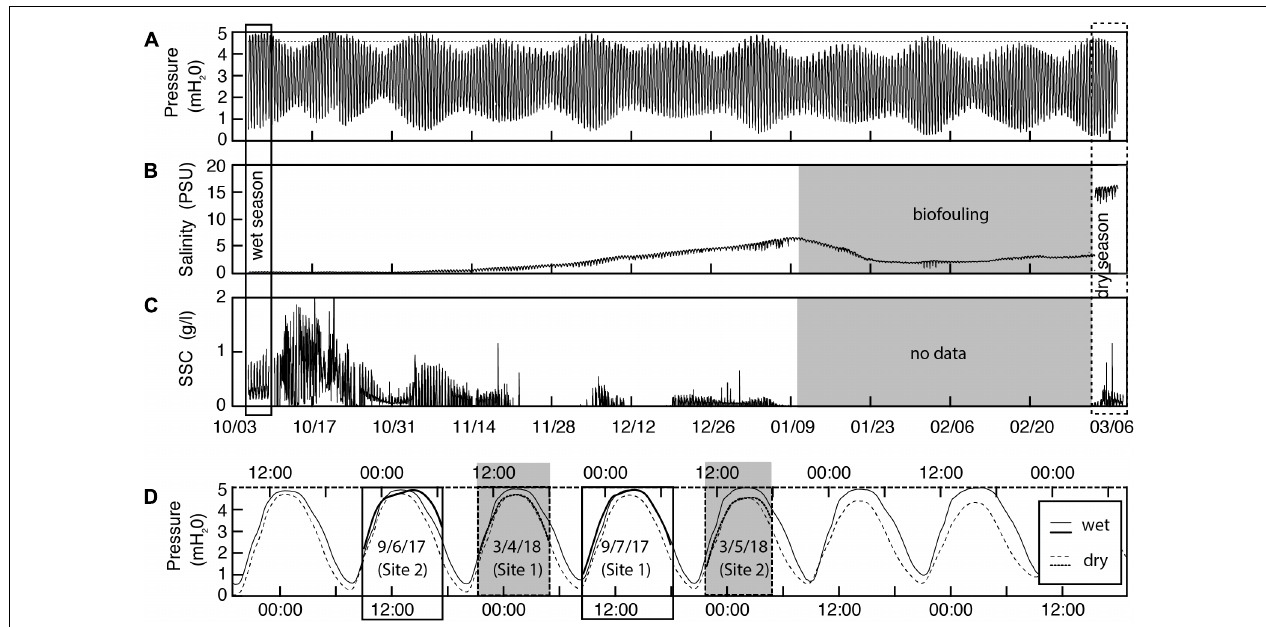
FIGURE 2 | Long-term observations of pressure (A) , conductivity (B) , and SSC (C) at SRFS, and focused observations of water level during the single-day observation periods at Sites 1 and 2 (D) . Wet and dry field seasons are outlined by solid and dashed boxes. Notice the general decrease in water level and SSC, and increase in conductivity during the dry season. The dashed line in panel (A) is the platform elevation at Site 1 for reference. For panel (D) , dashed and light solid lines are from SRFS, while dark solid lines are from Sites 1 and